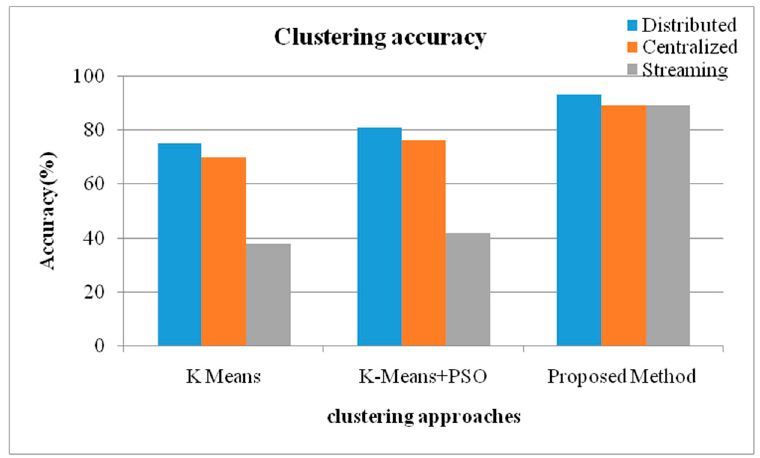
Figure 2. Clustering and analyzing accuracy comparison.